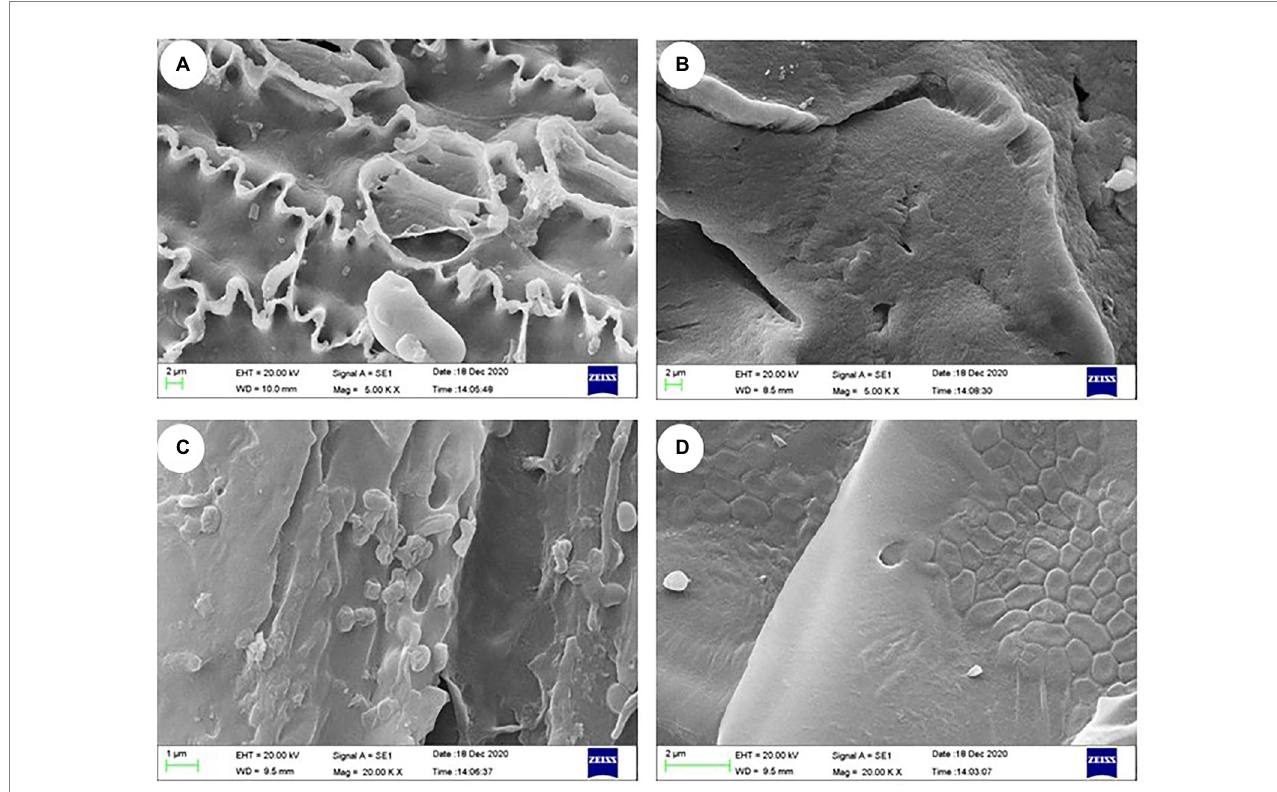
FIGURE 4 Scanning electron microscope observations of carrier materials (A) , immobilized carrier materials (B) , carrier materials containing bacterial suspensions (C) , and immobilized bacterial mixture (IM-FN) (D) .